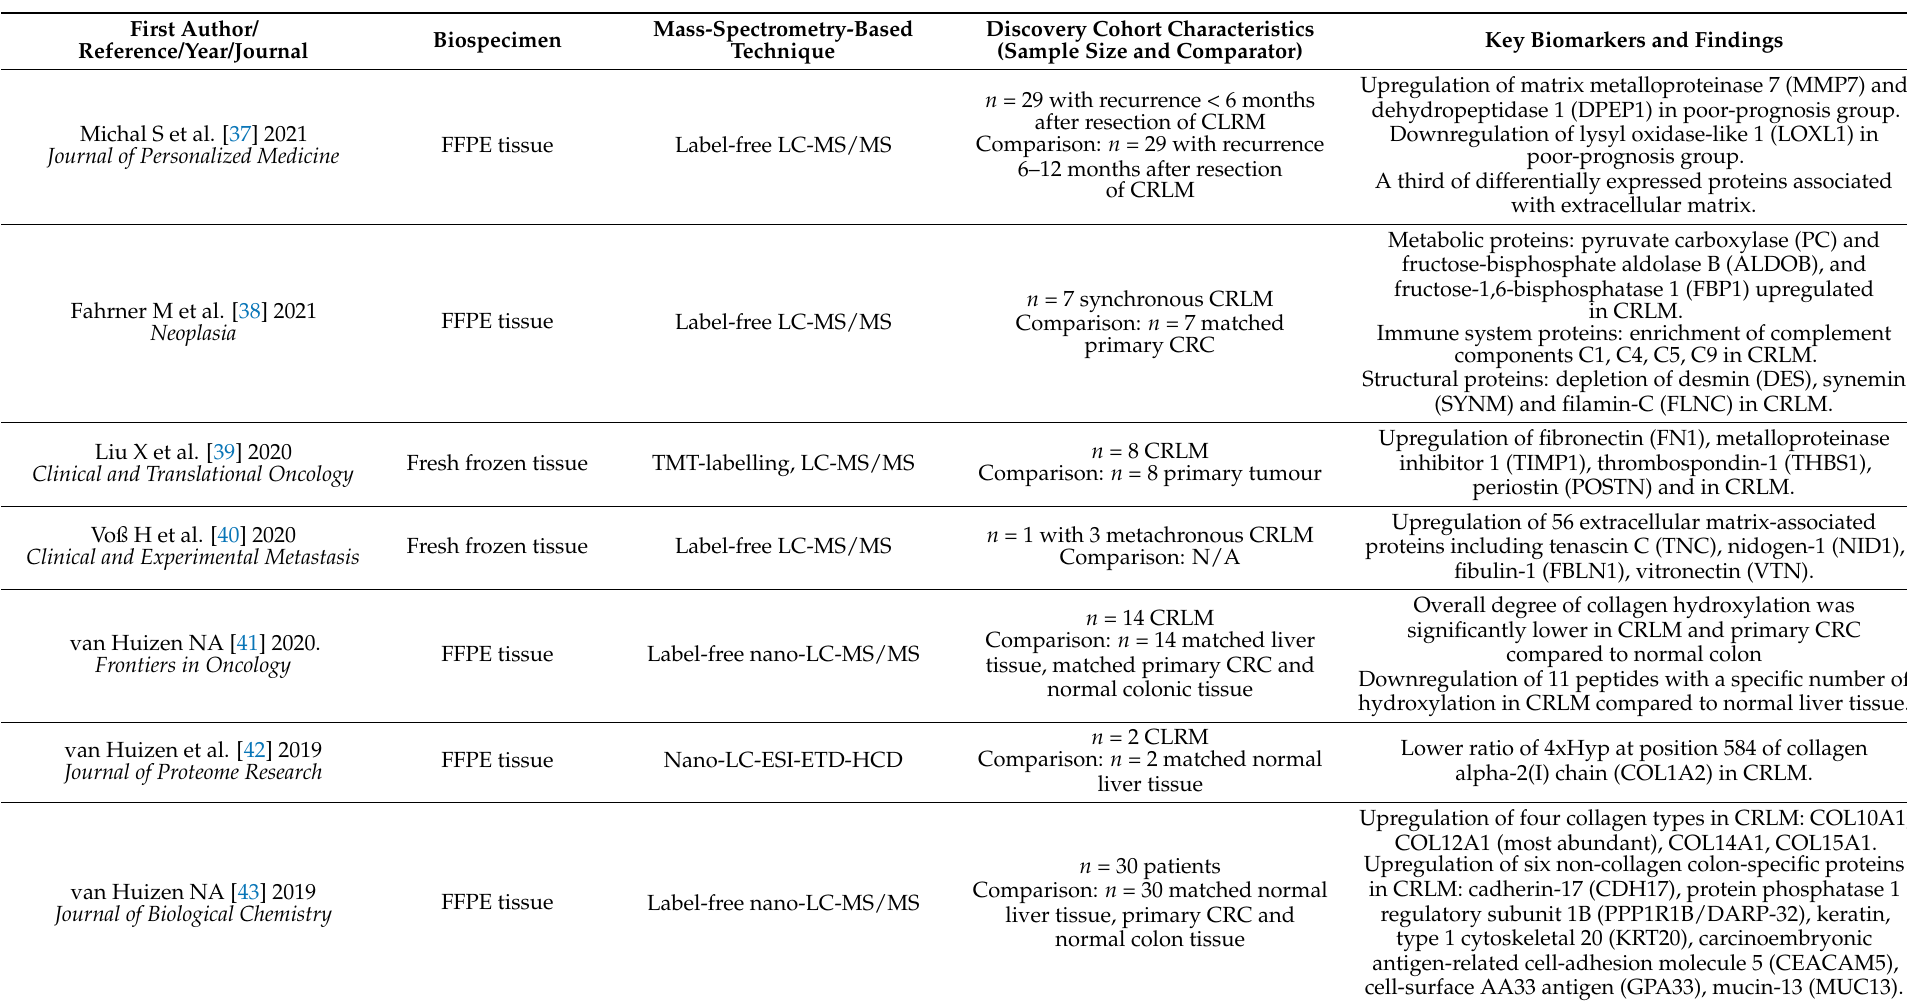
Table 1. Studies on the prognostic relevance of mass spectrometry-based proteomic biomarkers in human colorectal cancer liver metastases over the last 10 years in descending chronological